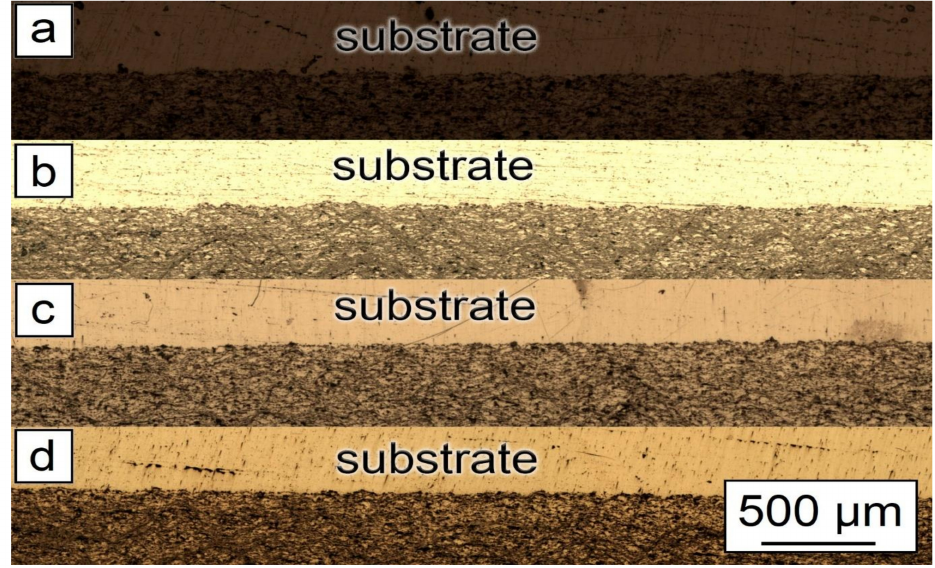
Figure 5. Morphology of samples after CSM: ( a ) 30% Al + 70% Al 2 O 3 ; ( b ) 29.5% Al + 70% Al 2 O 3 + 0.5% CNF; ( c ) 29% Al + 70% Al 2 O 3 + 1.0% CNF; ( d ) 28.5% Al + 70% Al 2 O 3 + 1.5%